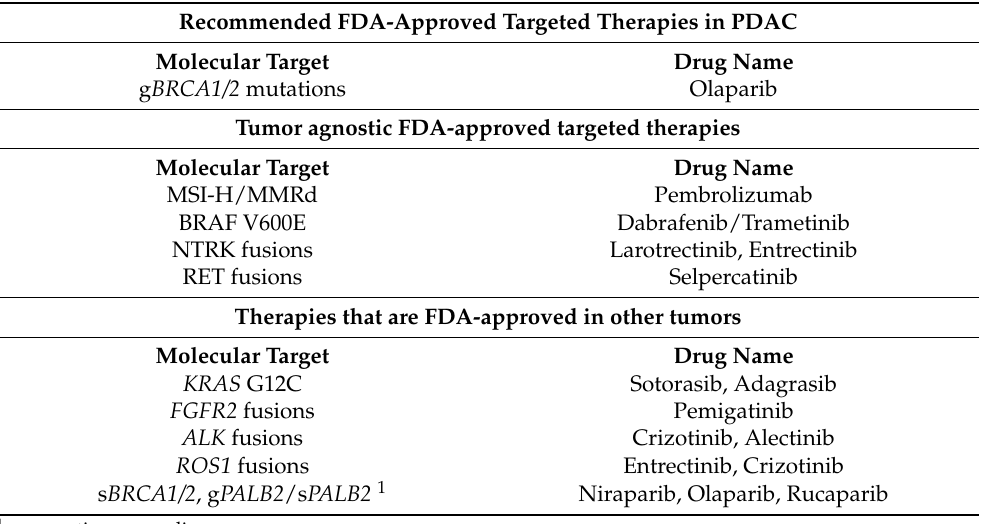
Table 1. Recommended FDA-approved targeted therapy options for PDAC.